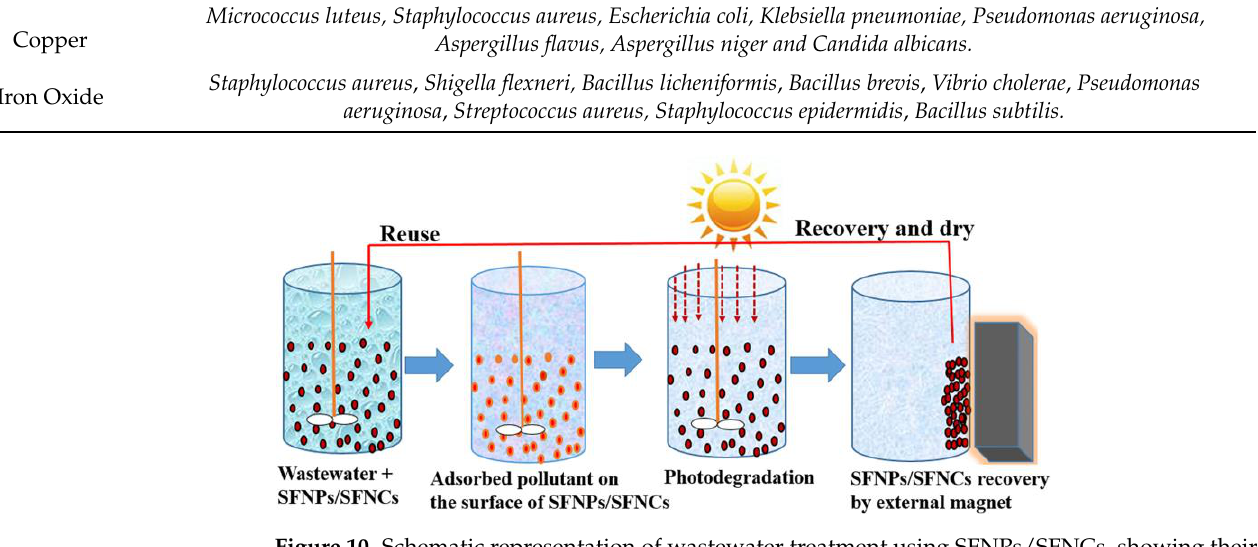
Figure 10. Schematic representation of wastewater treatment using SFNPs/SFNCs, showing their potential for recovery and reuse [125]. Table 5. Silver, copper and iron oxide nanoparticles and some of the pathogens they are effective against (adapted from [35,106,113]).